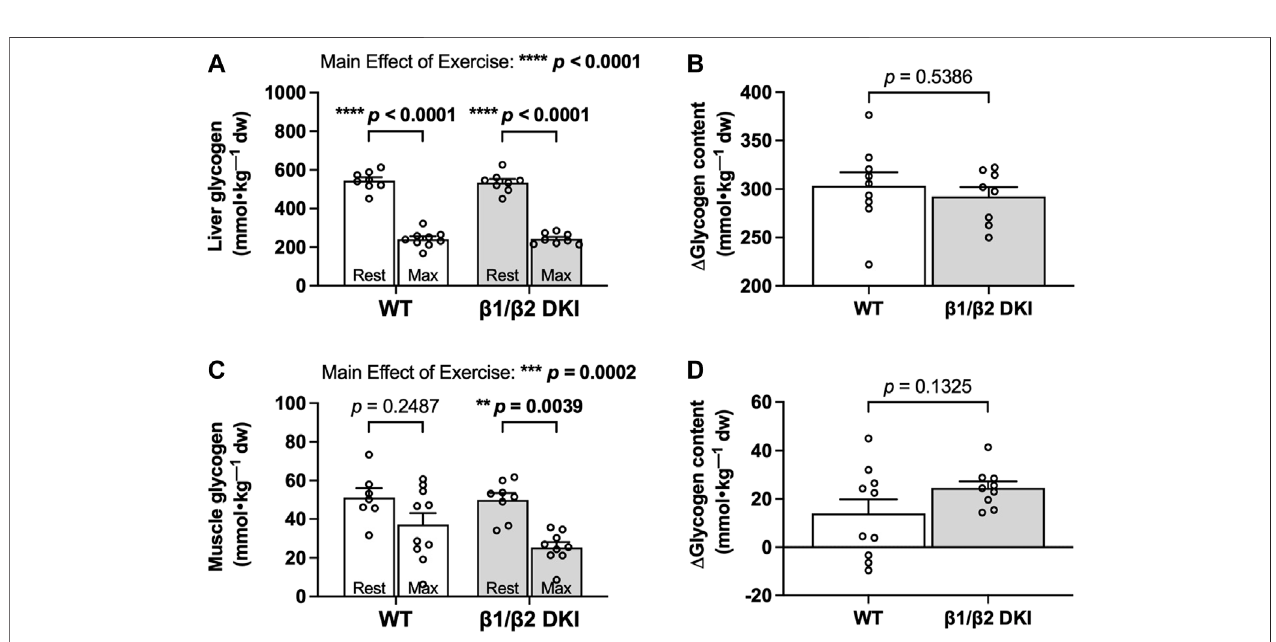
FIGURE 4 | DKI and WT mice display similar changes in liver and skeletal muscle glycogen following a maximal running test at a 5 ° incline. Glycogen content was assessed in (A) liverand (C) skeletalmusclefromrestedmice andmaximally exercised mice.Changeinglycogen( Δ glycogencontent)in (B) liverand (D) skeletalmuscle was determined by the difference between individual glycogen content of maximally exercised mice and the average glycogen content of rested mice from the same genotype. Male mice, 17 – 20 weeks, n = 7 – 10. ** p < 0.01, *** p < 0.001, **** p < 0.0001.